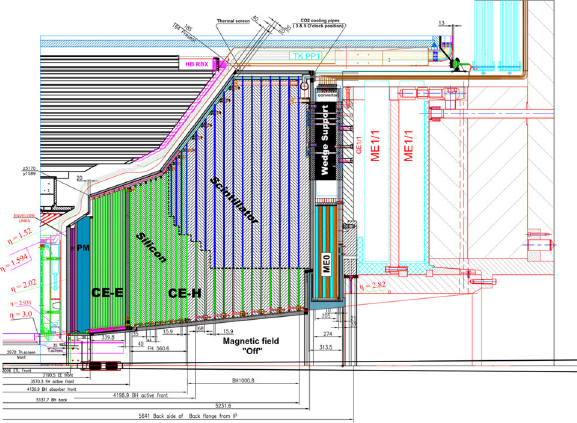
Fig. 3 Longitudinal cross-section of the upper half of the CMS endcap calorimeter [4]